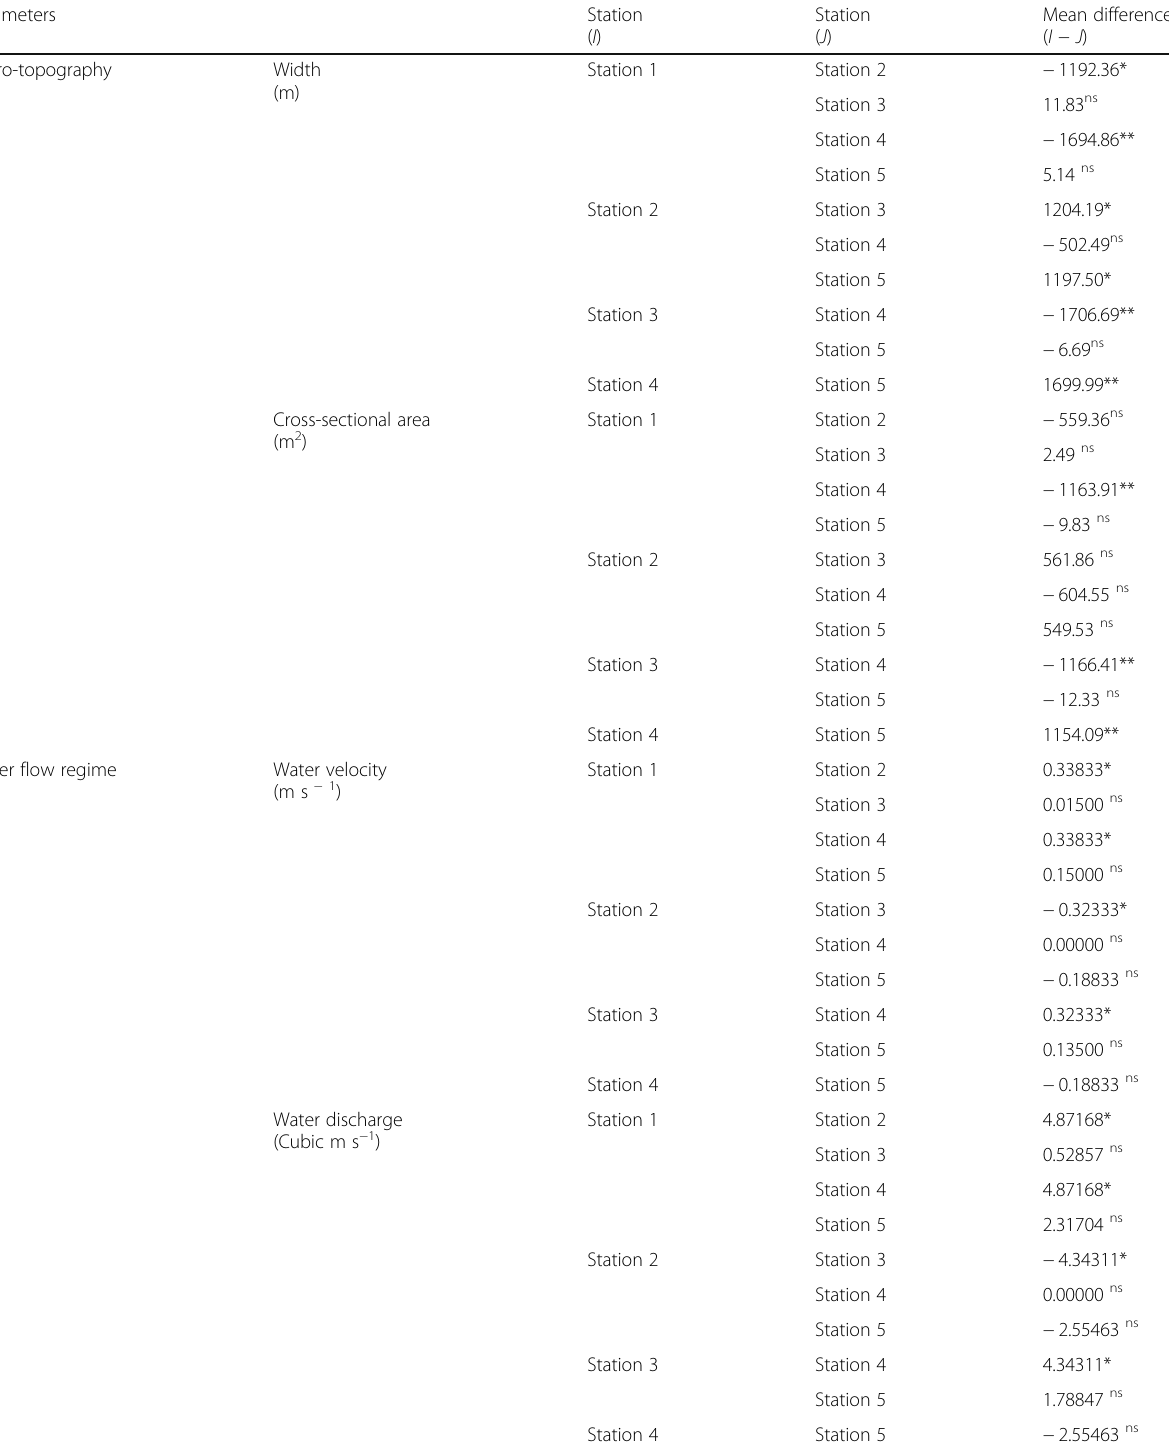
Table 5 Multiple comparisons of the micro-topography, and flow parameters in the wetland at different sampling stations using Tukey Post-hoc